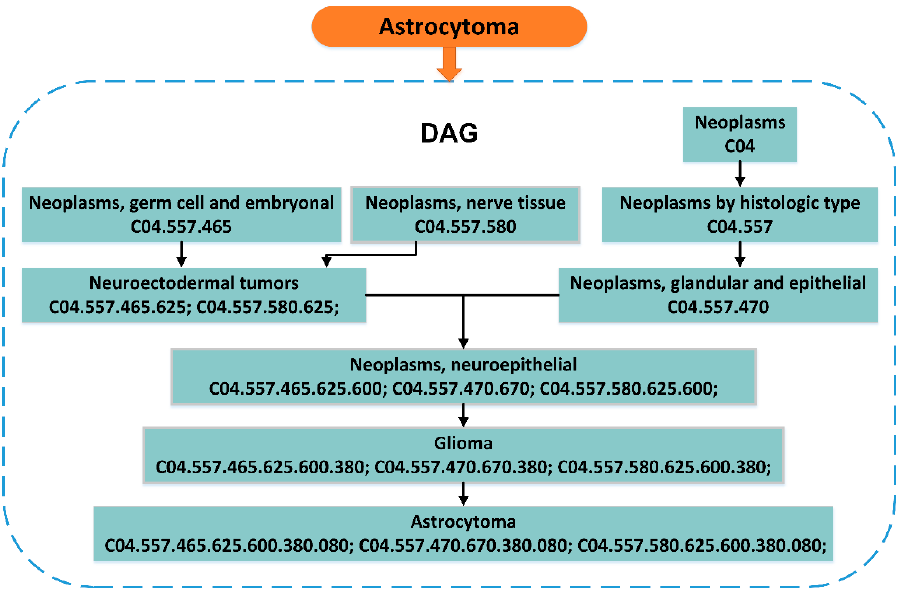
Figure 3. Construction of the Astrocytoma’s directed acyclic graph (DAG). Remove the last three digits of a Medical Subject Headings (MeSH) descriptor of the disease to get a new MeSH descriptor of a more abstracted disease. For example, Neoplasms, neuroepithelial, and the last three digits of its